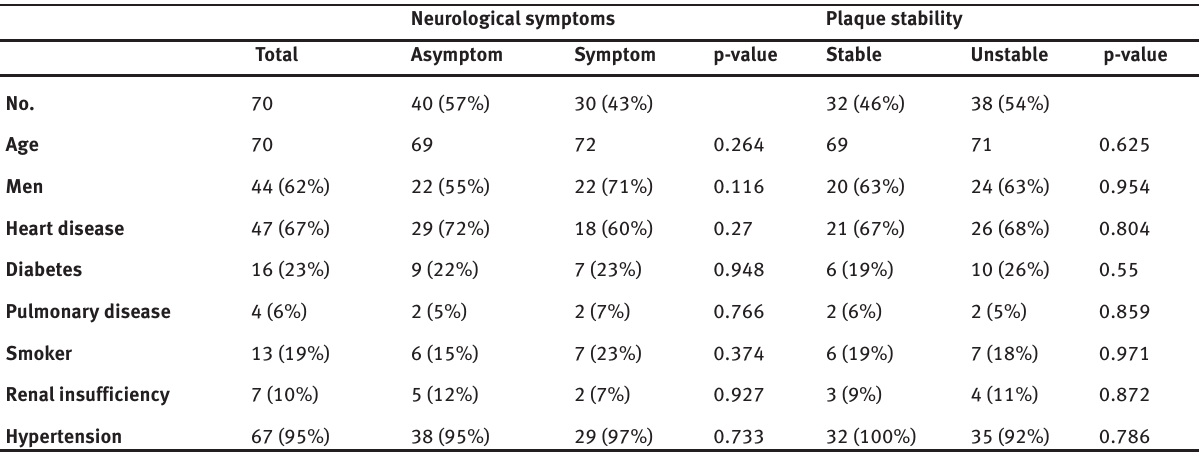
Table 1: Clinical characteristic of the study population.